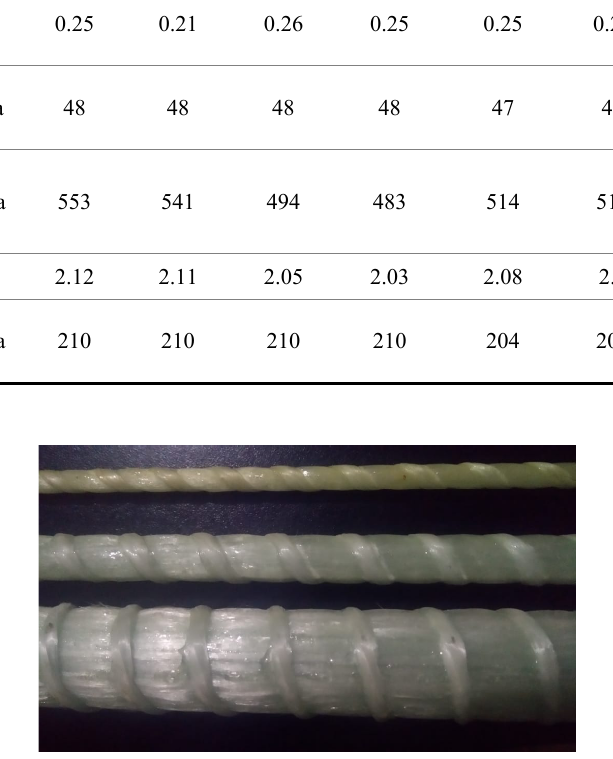
Figure 2. Ribbed GFRP bars.